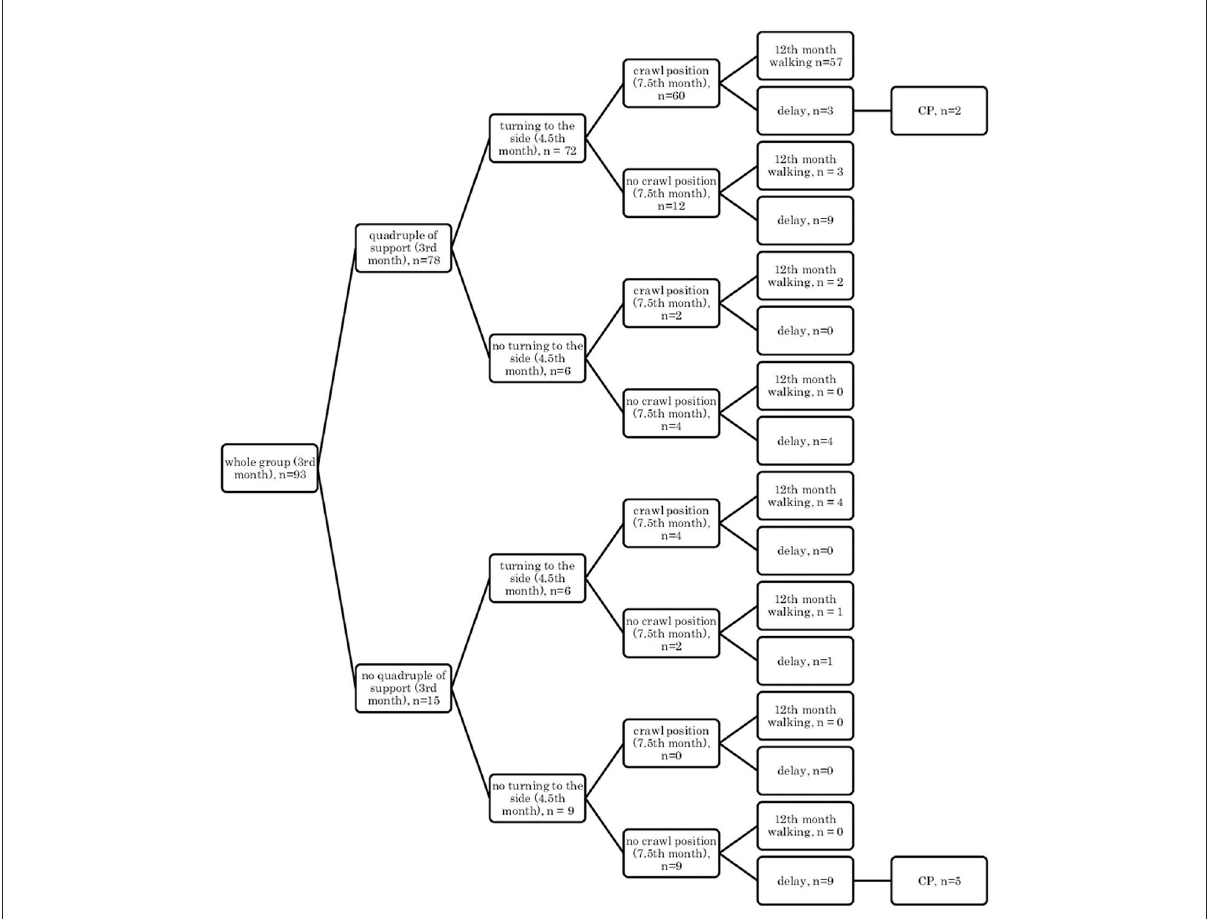
FIGURE2 Motor development in the prone position: symmetrical support (3rd month); asymmetric support (4.5th month); creeping (7.5th month), and independent walking (12th